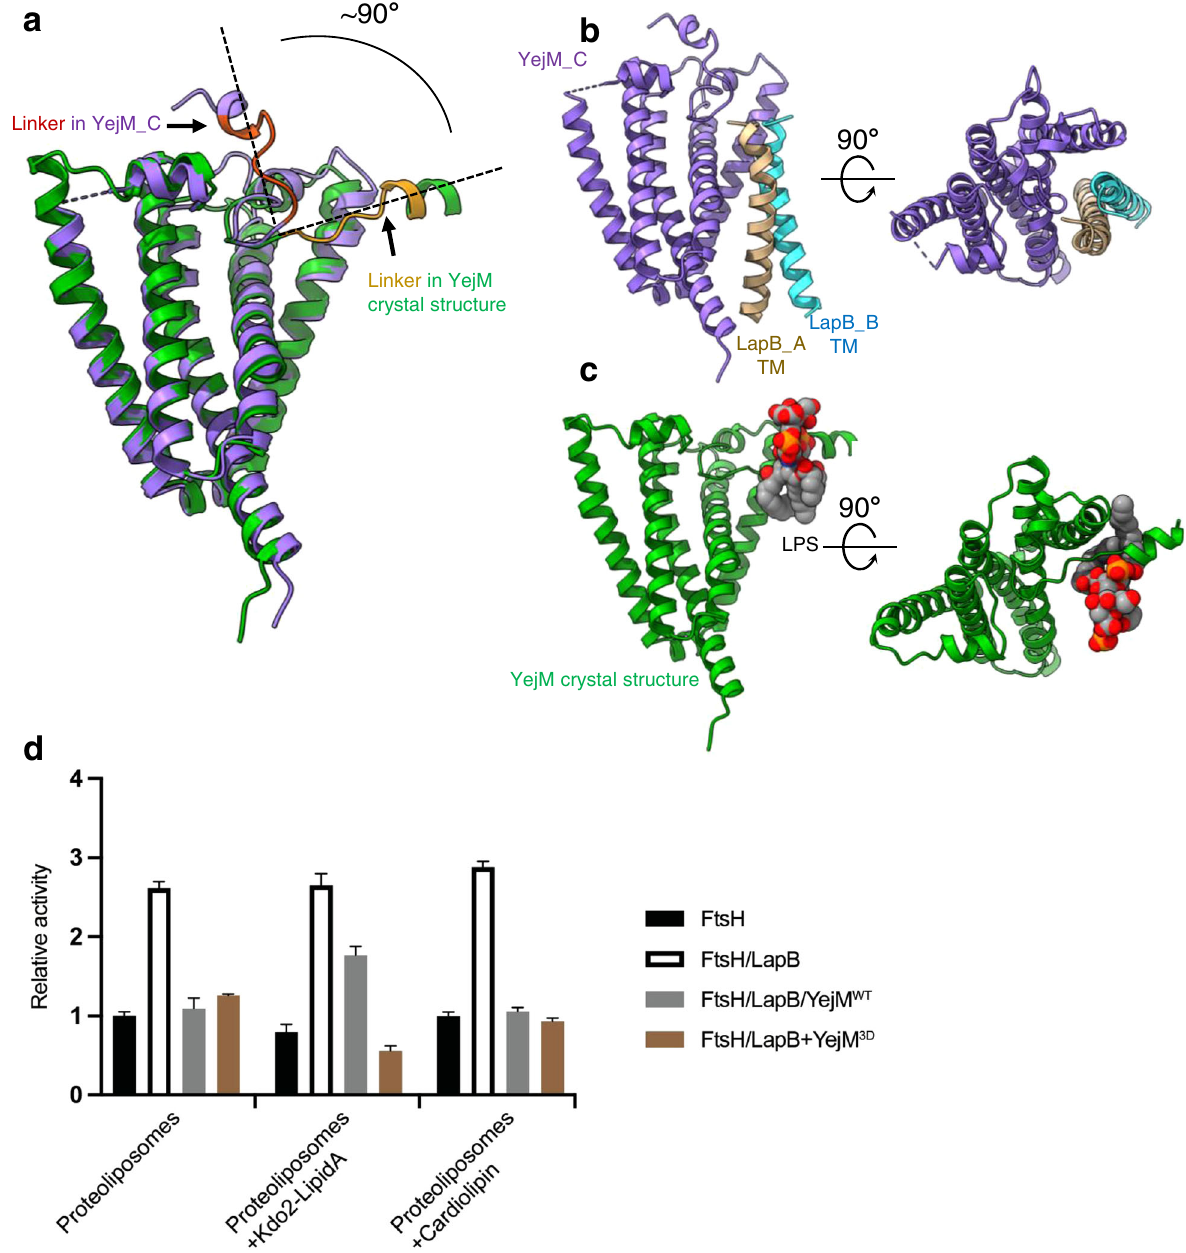
Fig. 4 | Structural comparison of the YejM/LapB and YejM/LPS complexes and protease assays with reconstituted proteoliposomes. a Structural comparison of the YejM_C molecule (purple, residues 210-YPMTARRF-217 in the linker region colored in orange) and the crystal structure of YejM (green, residues 210- YPMTARRF-217 in the linker region colored in dark yellow) (PDB ID: 6XLP), by superimposing the TM domains with an RMSD of 1.22Å in the main chains. The orientations of the linker in the two structures are highlighted with dashed lines. b Side and top views of the TM domains of the YejM_C and the LapB dimer. c Side